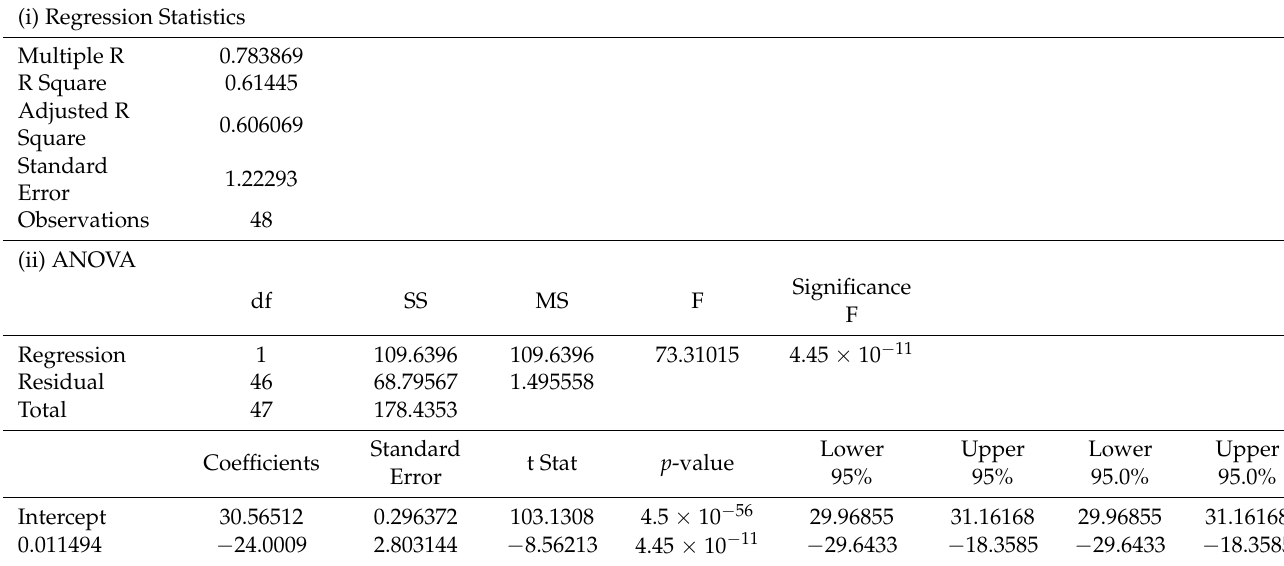
Table A2. Regression Statistics between LST and NDVI for